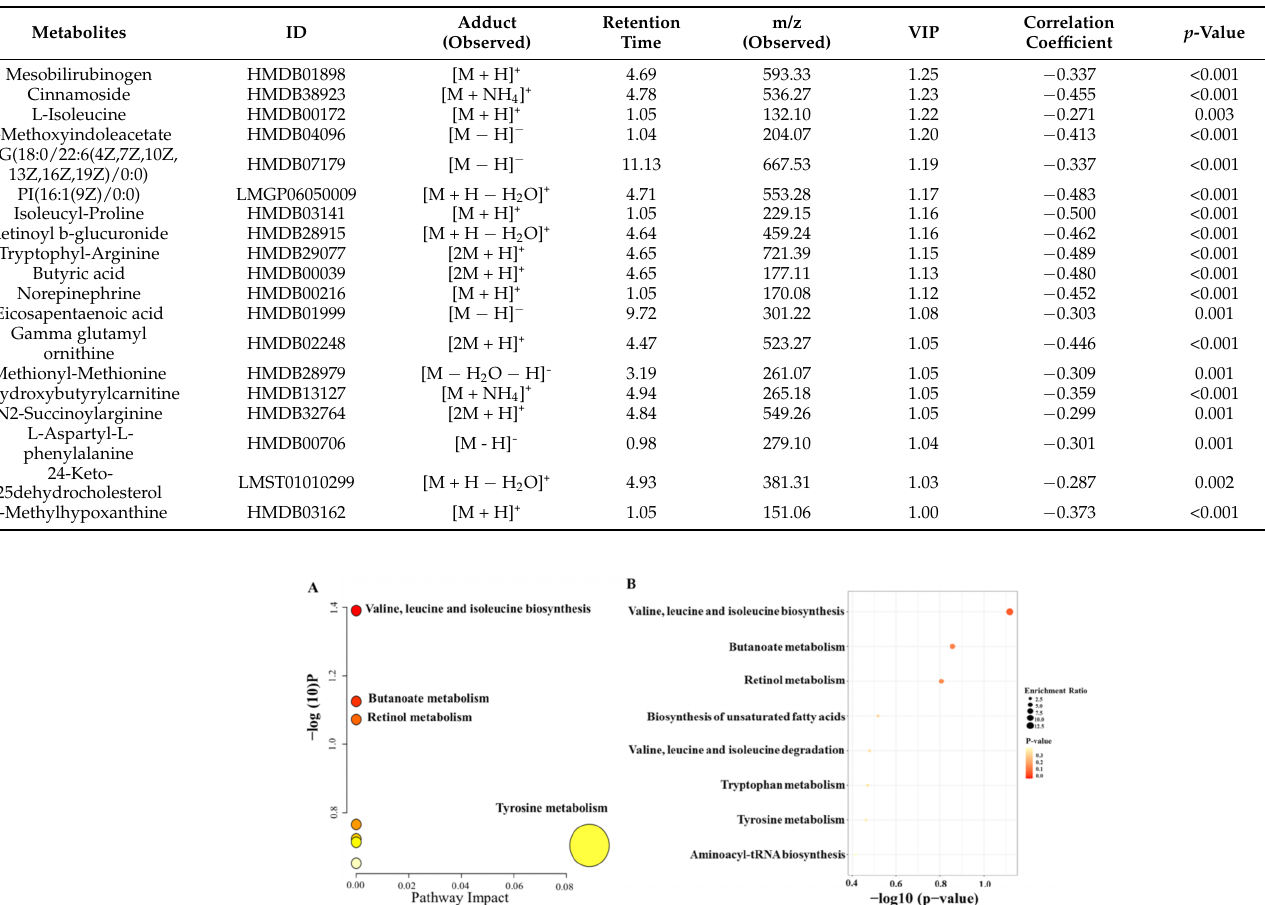
that the prediction capability of the model was reasonably high. Table 3. The summary of the 19 identified metabolites.